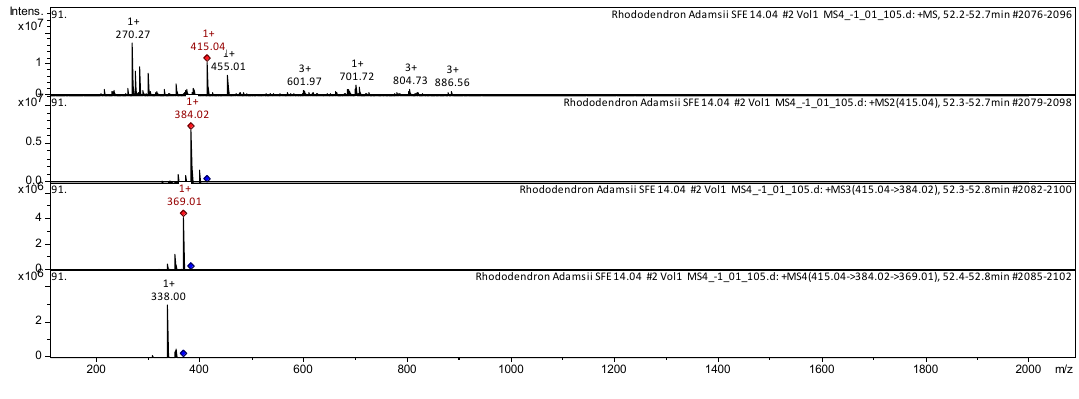
Figure 4. CID spectrum of Beta-sitosterin from Rh. adamsii , m / z 415.04.